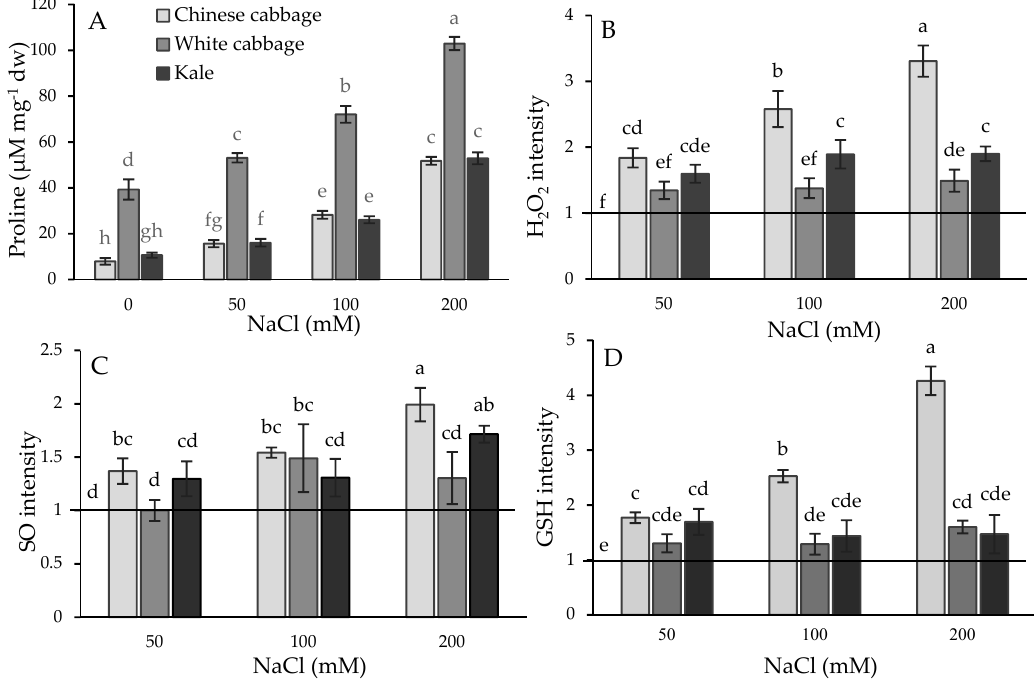
Figure 3. Biochemical stress markers: proline content ( A ) and fluorescence intensity due to the reactive oxygen species (ROS) H 2 O 2 ( B ), and superoxide (SO) ( C ), as well as glutathione (GSH) ( D ) in the roots of Chinese cabbage, white cabbage, and kale seedlings under increasing salt concentrations (0, 50, 100, and 200 mM NaCl). Data in figures B, C, and D were normalized according to the corresponding controls (horizontal lines normalized to 1). Data are averages ± SD ( n = 5). Points labeled with different letters differ significantly at p < 0.05.